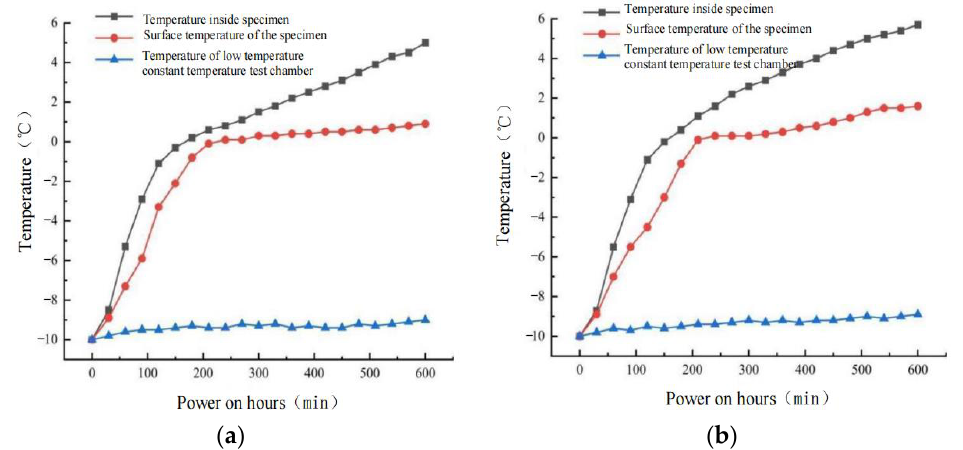
Figure 22. Melting ice and snow test results under different dosage. ( a ) 0.3% carbon fiber + 0.5% graphene content. ( b ) 0.3% carbon fiber + 0.6% graphene.